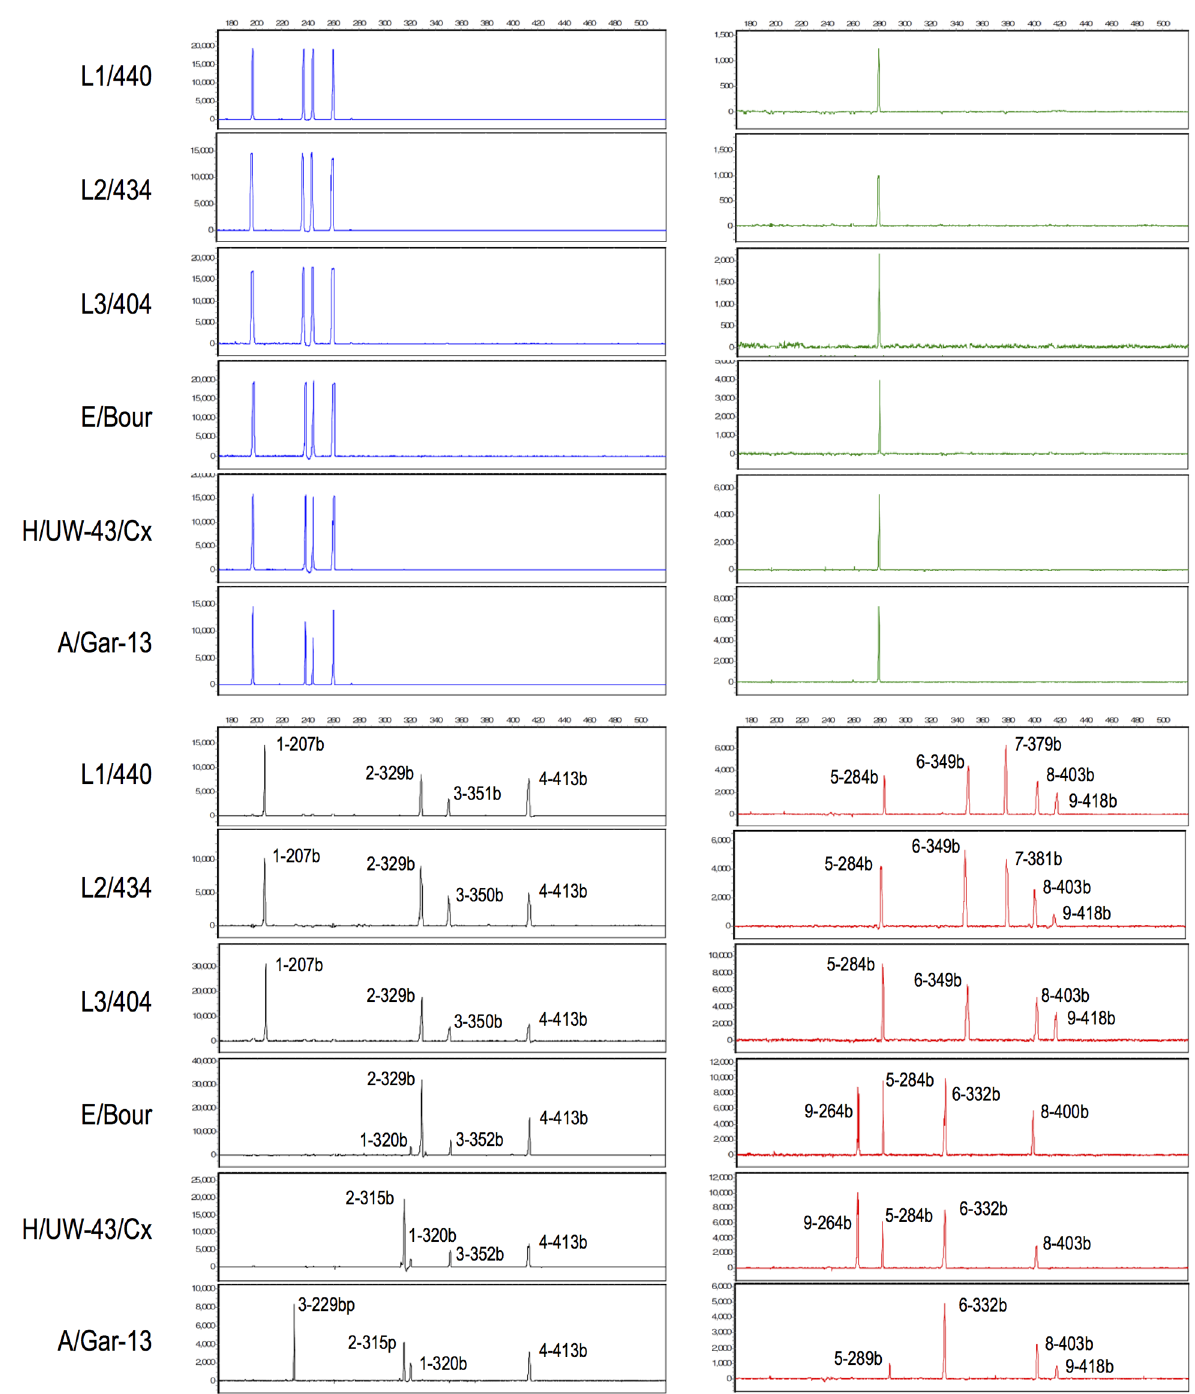
Fig 1. Generated 13-plex PCR electropherograms from six representative Ct strains: LGV strains L1/440, L2/434 and L3/404, urogenital strain E/Bour, proctocolitis strain H/UW-43/Cx and ocular strain A/Har-13. The FAM (blue), TMR (yellow but presented as black in the output profiles) and ROX (red) labeled-FLTsare aligned to illustrate ampliconsizes from the set of six strains. Targets and ampliconsizes in bases (b) are indicatedto show variationsobservedamong strains in the TMR and ROX channels(Peak 1 = IGS-101; Peak 2 = IGS-102; Peak 3 = IGS-103; Peak 4 = mdh C; Peak 5 = IGS-104; Peak 6 = IGS-105; Peak 7 = omp A; Peak 8 = IGS-106; and Peak 9 = IGS-107). Ampliconsizes in FAM are conservedand not numbered.The internal control ampliconis JOE-labeled (green). X- axis: fragment size in bases; Y-axis: relative fluorescence units